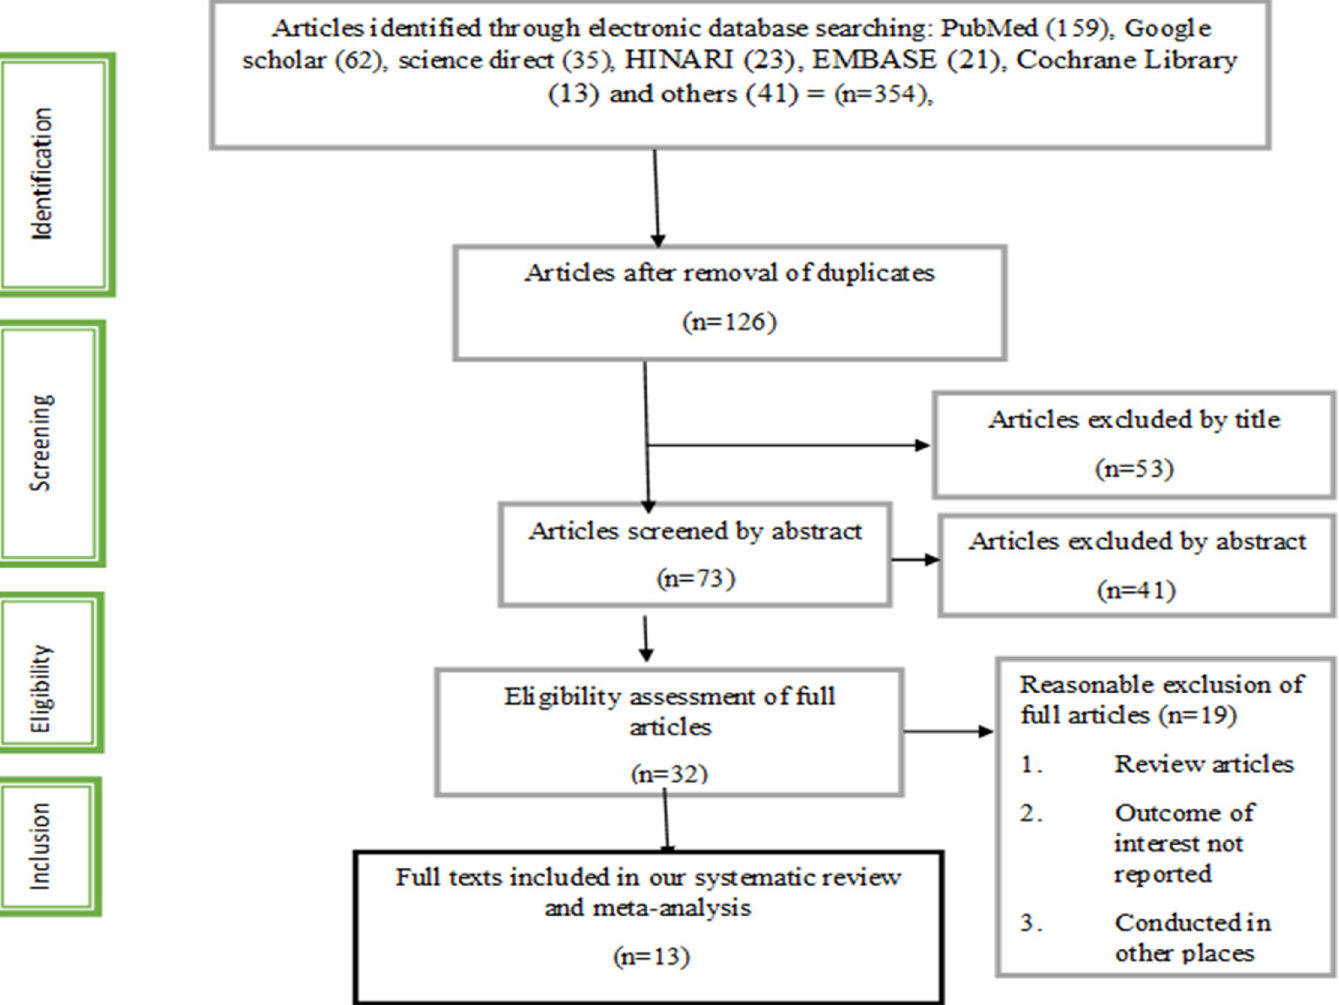
Fig 1. Flow chart diagram describing selection of studies for the systematic review and meta-analysis of prevalence and determinants of non-adherence to anti TB medication in Ethiopia, 2018.